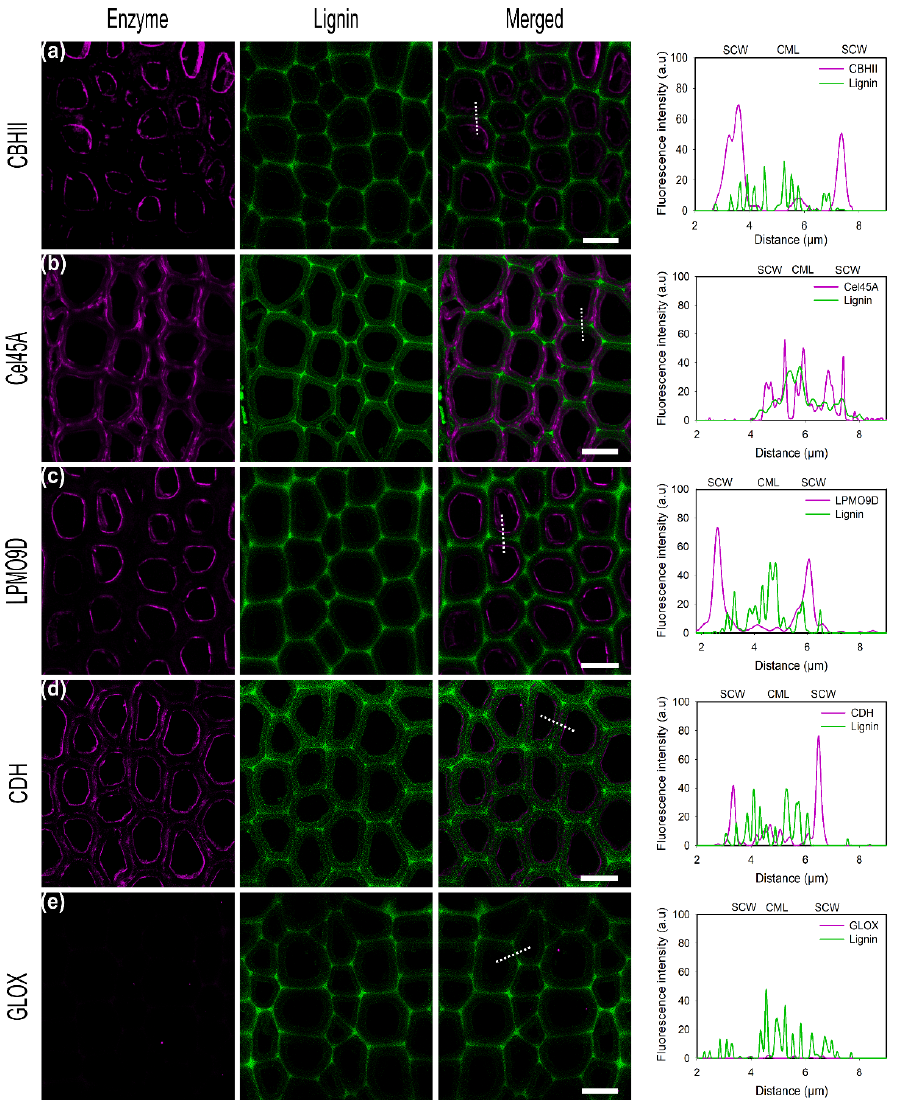
Figure 3. CLSM images of conjugated enzymes ( a ) CBHII, ( b ) Cel45A, ( c ) LPMO9D, ( d ) CDH, ( e ) GLOX on poplar cross-sections showing fiber cells. Enzyme fluorescence is colored in magenta. Lignin autofluorescence is shown in green. Merged column displays the overlay of enzyme and autofluorescence channels. Graphs showing the overlay profile (dash line) of line scans over fiber cell wall, showing secondary cell walls (SCW) and compound middle lamella (CML). The bright- ness was enhanced to allow proper visualization using the same factor. Scale bars correspond to 10 µm. CDH showed the highest intensity at the inner part of the cell wall corresponding to the S3 layer as also observed for CBHII (Figure 3d). Although some fluorescence could be detected in the compound middle lamella regions (CML), the intensity found within the cell walls was three times higher (SCW), suggesting only minor unspecific binding to- wards lignin. Although CDH from P. chrysosporium does not contain a CBM as found with many CDHs from ascomycetes, a strong affinity towards cellulose has been demonstrated in previous studies [57]. The observed binding pattern, with only a low